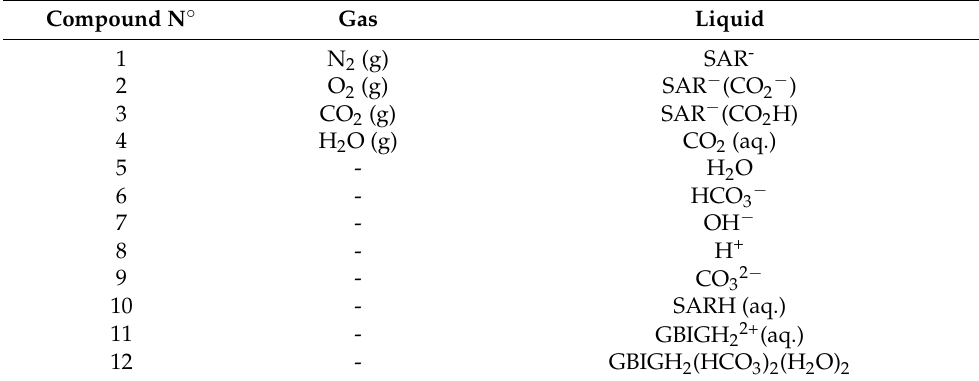
Table A1. List of compounds participating in the reaction scheme.